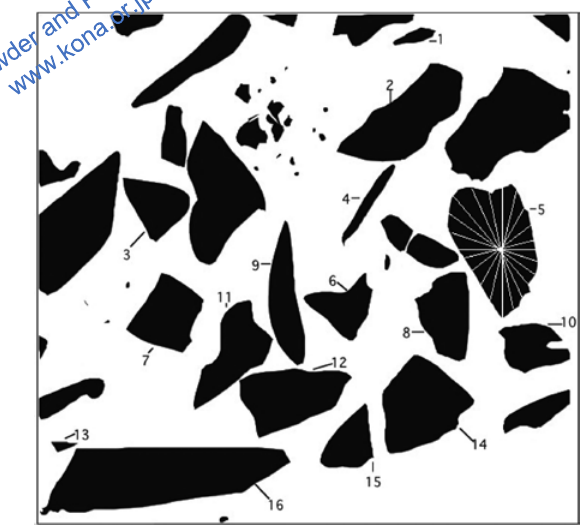
Fig. 1 Silhouette Image of Polished Face the UF 200 × 400 Cut Embed- ded in Resin.